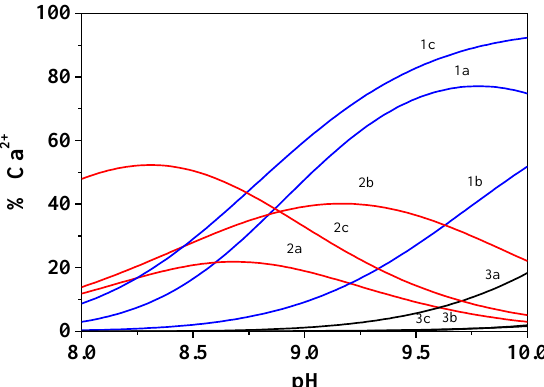
Figure 4. Distribution diagram for the Ca 2+ /Dop − species at T = 298.15 K and different ionic strengths. Species: 1 ML; 2 MLH; 3 MLOH. a: I = 0.143 mol dm −3 ; b: I = 0.472 mol dm −3 ; c: I = 0.933 mol dm −3 . (Experimental conditions: c Ca2+ = 1.5 mmol dm −3 ; c DOP− = 5 mmol dm −3 ) [M = Ca 2+ ; L = Dop − ].